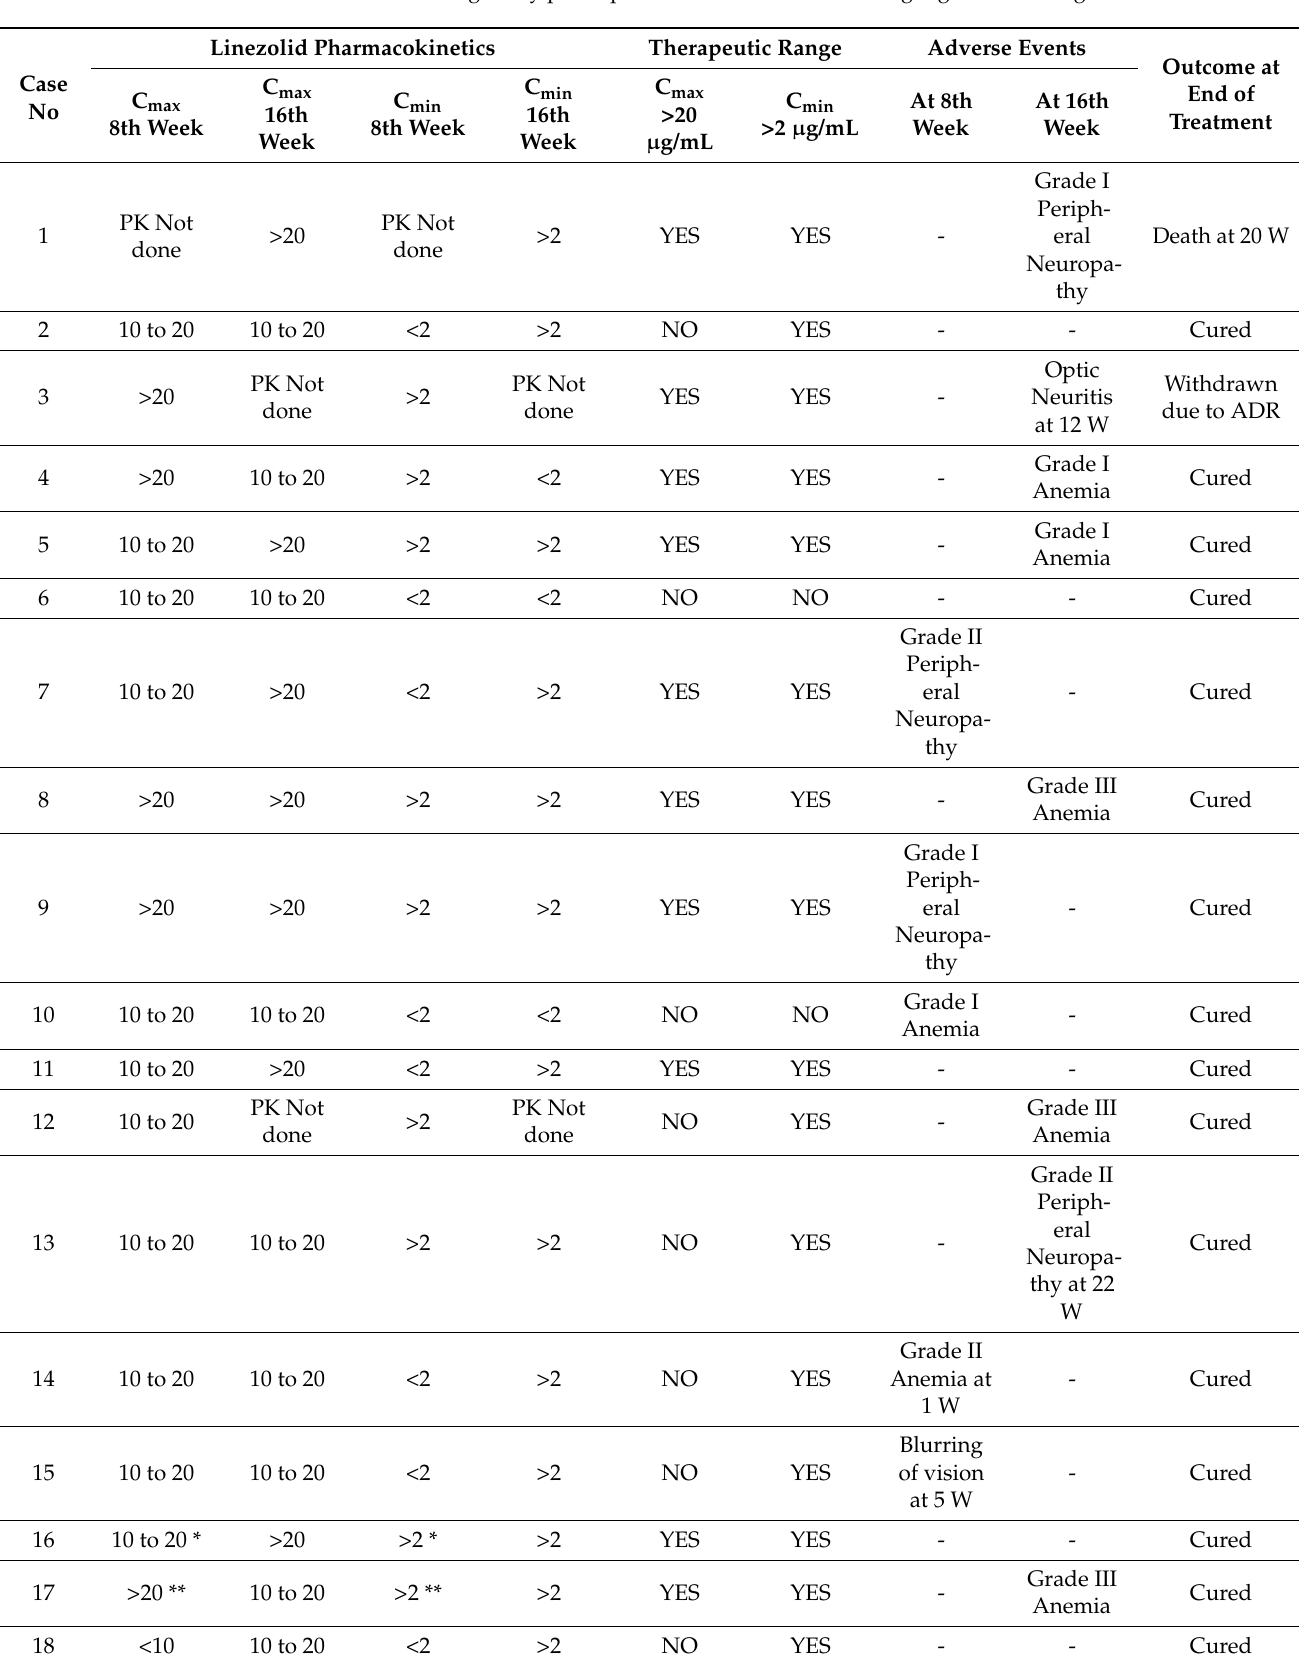
Table 2. Co-relation between the pharmacokinetic values of linezolid and adverse events with their outcome among study participants on a linezolid-containing regimen for drug-resistant